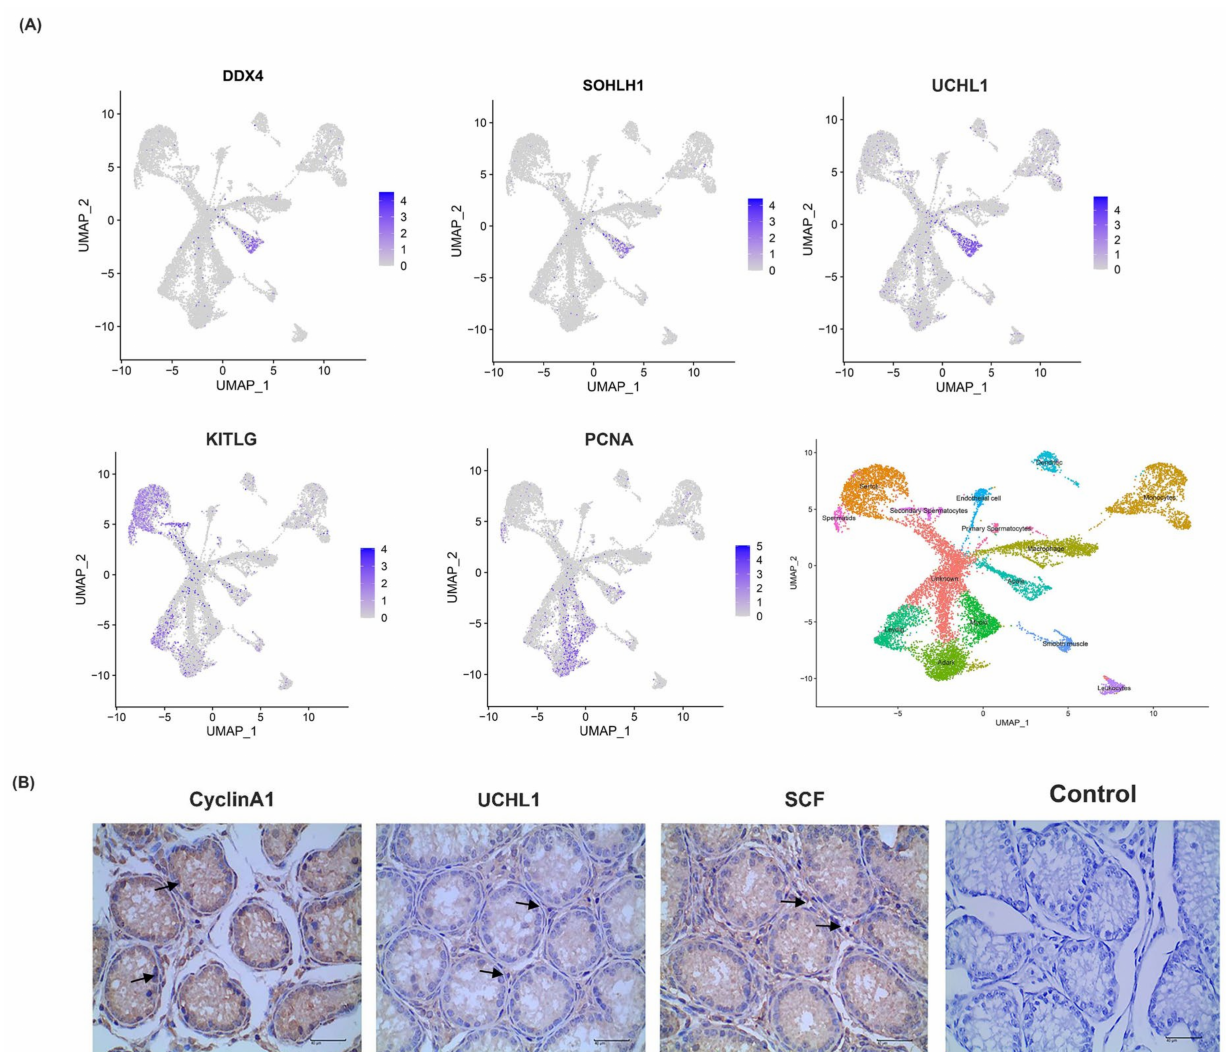
Figure 6. Expression and distribution of several potential genes. ( A ) The expression distribution of DDX4, SOHLH1, UCHL1, KITLG, and PCNA in sheep testicular cells. ( B ) Immunohistochem- istry analysis of the expression location of CyclinA1, UCHL1, and SCF in sheep testis. The testis morphology was observed under 400 × magnification by a